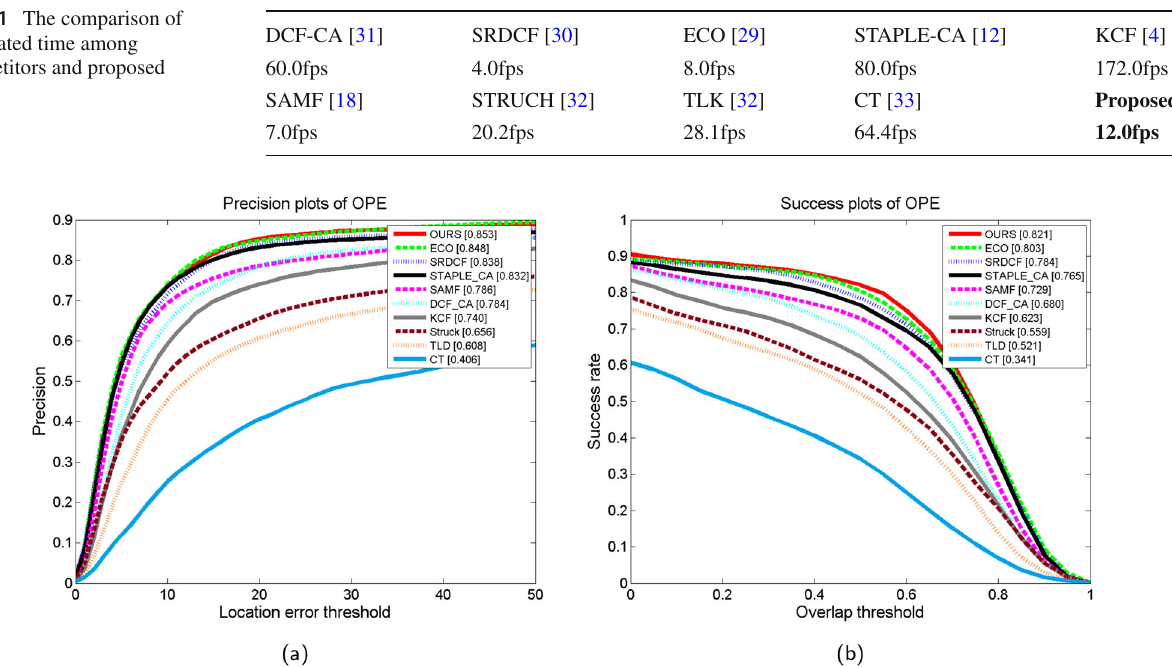
Fig. 6 The comparison success rate on the OTB-50 test video (red line is